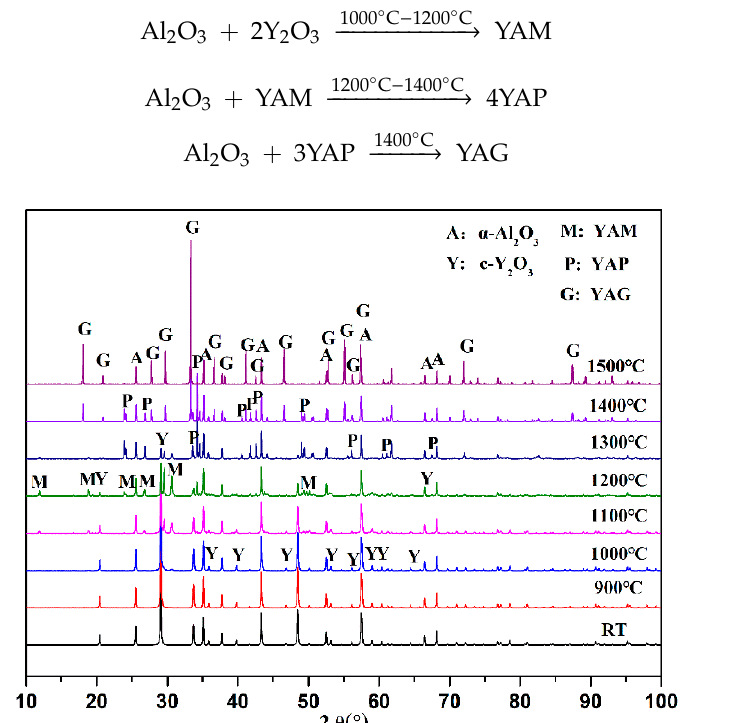
Figure 2. XRD patterns of spray granulation Al 2 O 3 –Y 2 O 3 powder and powder calcinated at different temperatures for 2 h.